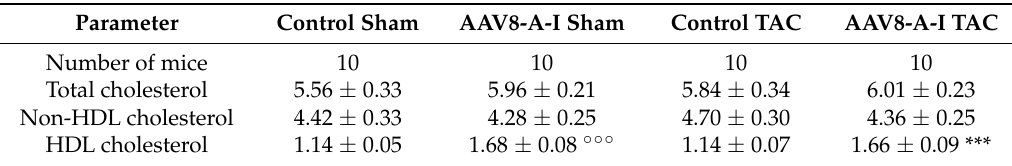
Table 1. Total, non-HDL, and HDL cholesterol plasma levels (mmol/L) in C57BL/6 LDLr − / − mice 10 weeks after gene